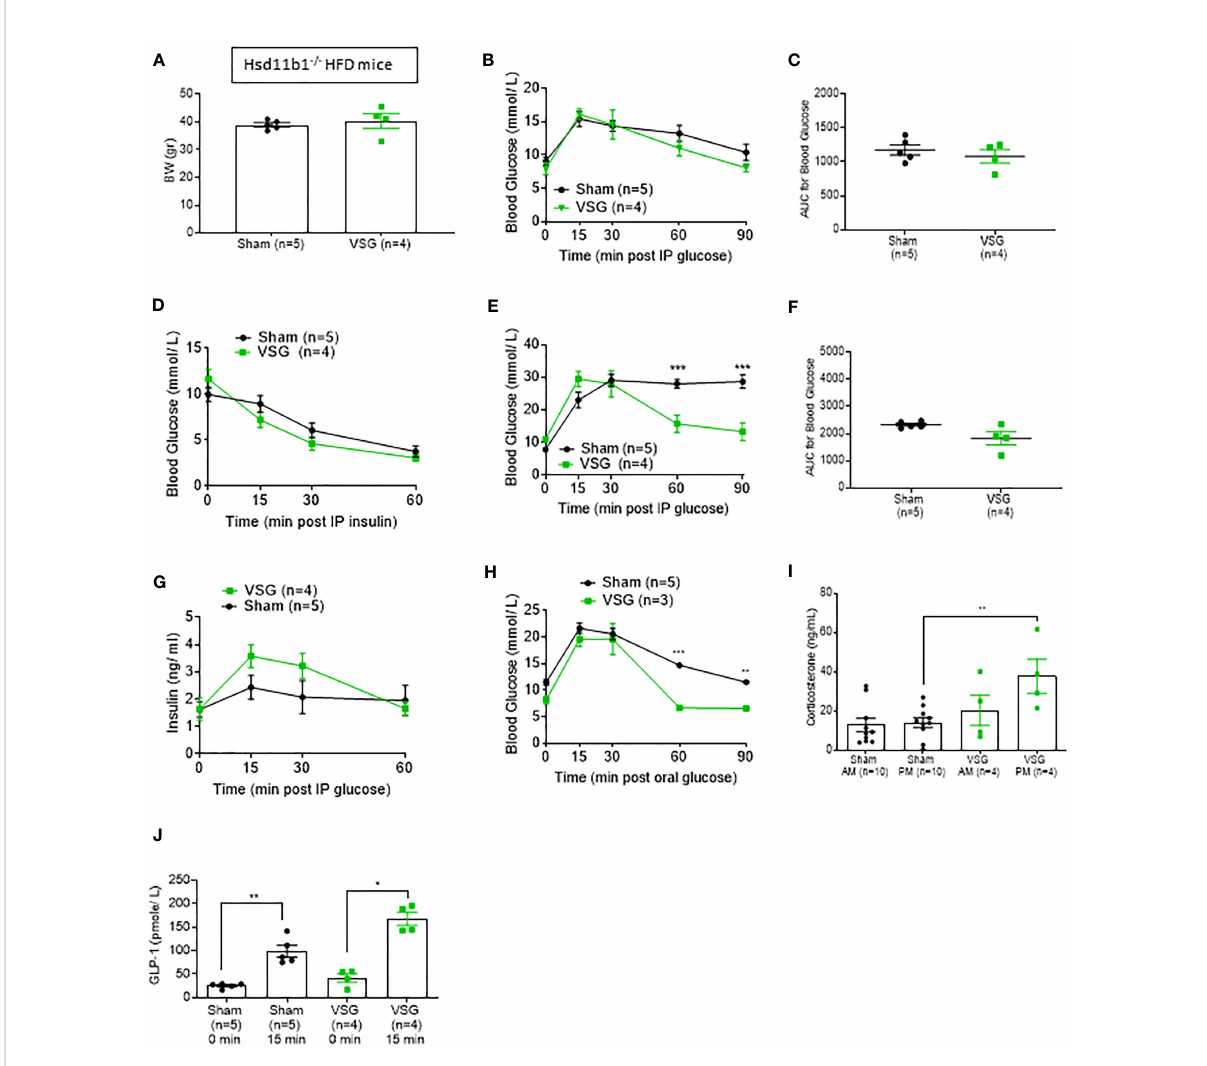
FIGURE 5 Hsd11b1 -/- mice display improved glucose tolerance. (A) Body weight of Hsd11b1 -/- HFD mice during 10 weeks post VSG and sham. (B) IPGTT (1 g/kg) 8hr fasting ten weeks after surgery on Hsd11b1 -/- HFD mice (C) Area Under the Curve for (B) (D) Insulin tolerance test in HFD mice (1.5 IU/kg) 6hr fasting, ten weeks after surgery (E) IPGTT in HFD mice (3 g/kg) overnight fasting ten weeks after surgery, ***p < 0.001 (F) Area Under the Curve for (E) (G) Insulin concentration measured during ipGTT (3 g/kg) overnight fasting [shown in (E) ] (H) Oral GTT (3 g/kg) overnight fasting 6 weeks post-op *P < 0.05 ***P < 0.001 KO sham vs. KO VSG following 2-way ANOVA (I) Corticosterone measurement following blood collection at 0800 and 1900 within the same day, ten weeks after surgery **P < 0.001 by two-sided paired Student ’ s t – test. Data are expressed as means ± SEM. (J) GLP-1 plasma levels following OGTT (3g/kg) overnight fasting *p < 0.05, **P < 0.001 by two-sided paired Student ’ s